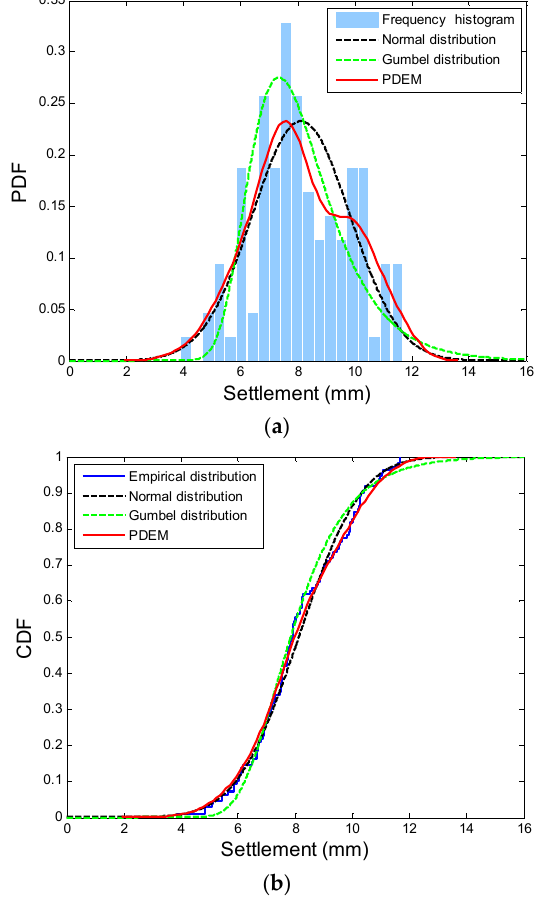
Figure 16. Comparison of the ( a ) maximum settlement PDF and ( b ) maximum settlement CDF at the RC pile head obtained using the PDEM and various distribution